Question: Express in one sentence what the figure is showing.
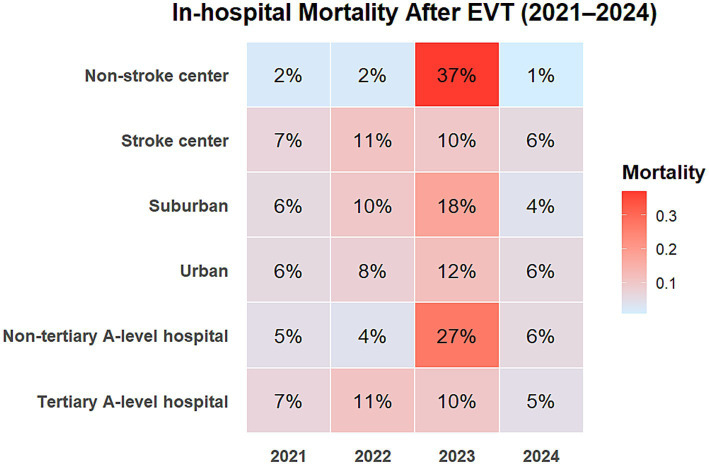
Answer: In-hospital mortality following EVT, stratified by hospital level, region and stroke center designation (2021–2024). This heatmap visualizes annual in-hospital mortality rates among AIS patients receiving EVT, categorized by geographic region (urban vs. suburban), hospital level (tertiary A-level vs. non-tertiary A-level) and stroke center designation (stroke center vs. non-stroke center). Mortality is expressed as the proportion of EVT patients who died during hospitalization in each subgroup. Color intensity corresponds to mortality rates, with darker red indicating higher rates. AIS, acute ischemic stroke; IVT, intravenous thrombolysis; EVT, endovascular thrombectomy.